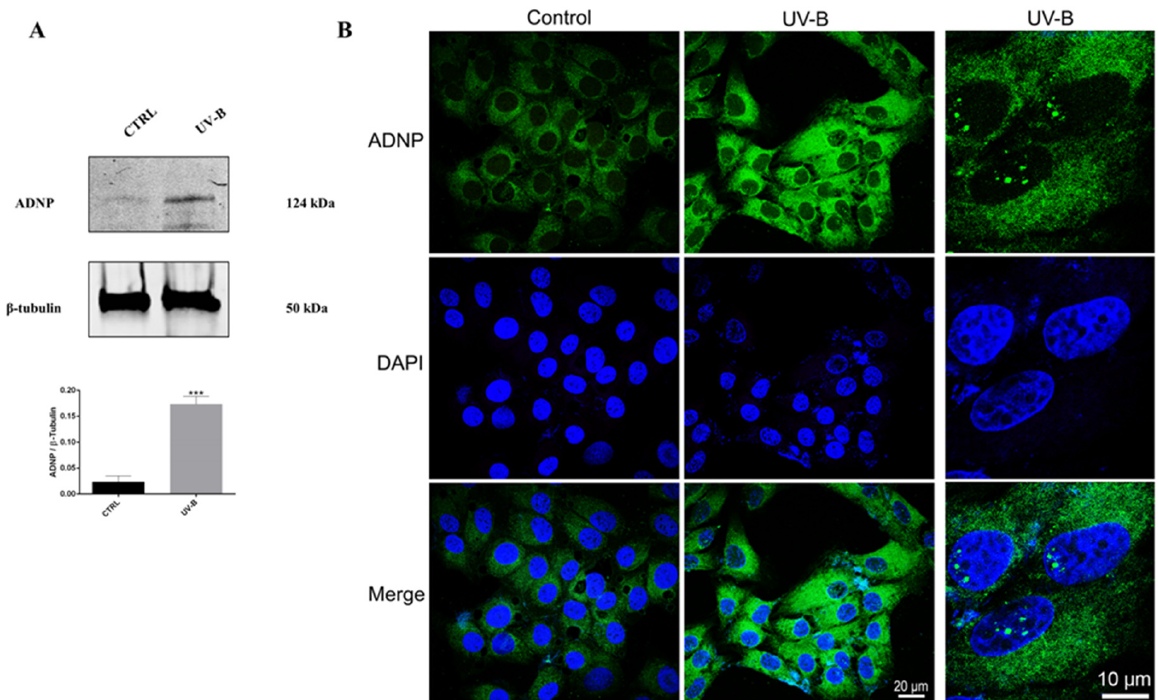
Figure 2. Expression of ADNP in SIRC cells exposed to UV ‐ B radiations. ( A ) Representative immunoblots of ADNP expression in SIRC cells following exposure to UV ‐ B insult. The bar graph shows quantitative analysis of signals obtained by immunoblots resulting from three independent experiments. Relative band densities were quantified using ImageJ software. Protein levels are expressed as arbitrary units obtained following normalization to b ‐ tubulin, which was used as loading control. Data represent means ± SEM. *** p < 0.001 vs. CTRL, as determined by unpaired two ‐ tailed Student t ‐ test. ( B ) Representative photomicrographs showing ADNP expression (green) in SIRC cells exposed to UV ‐ B radiations. Nuclei were stained with DAPI. Photomicrographs are representative results of fields taken randomly from each slide and scanned by confocal laser scanning microscopy (CLSM; Zeiss LSM700). In the right column, a thin section (0.3 μ m) with some SIRC cells showing ADNP in the euchromatic compartment of the nuclei is shown. Scale bar in the left and middle columns is 20 μ m, and in the right column is 10 μ m.